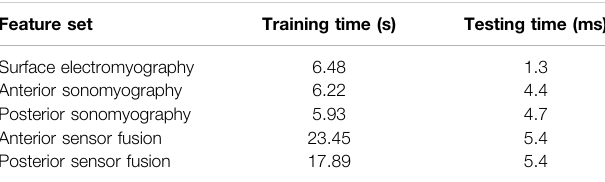
TABLE5| Mean(SD)computationaltimetotraintheGaussianprocessregression model using three separate feature sets containing strides from all fi ve ambulation tasks and test on individual strides ofeach ambulation task for thehip, knee and ankle. Feature